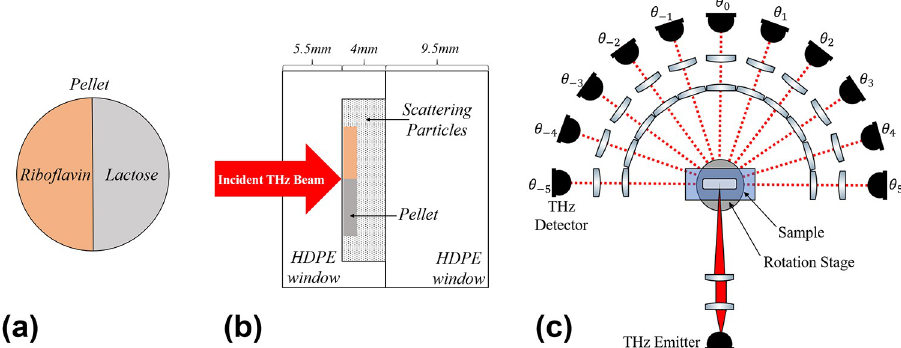
Fig 1. Sample and experimental setup. (a) The pellet with two different materials with unique spectral peaks in the THz regime is shown. (b) The sample location is shown in a cross-section of the sample holder which is made from two HDPE slabs. (c) The optical setup used for measuring diffused granular scattering signal is depicted. The THz detector arm was on a rotation stage and measurement angles, θ ± n , were in steps of